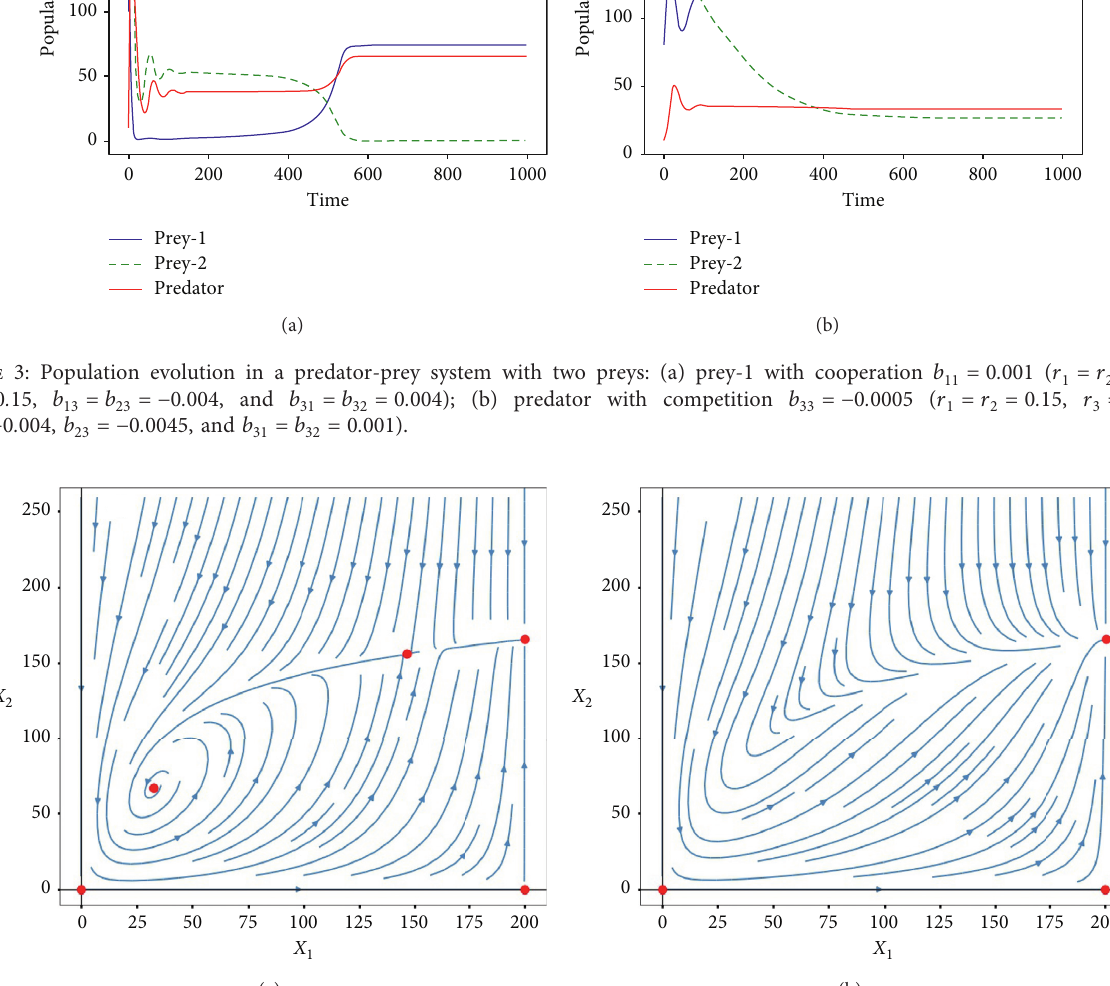
Figure 4: Phase space and trajectories for two populations involved in a predator-prey interaction. To the left, we have a case with a lower b � 0 . 0028 than to the right, b � 0 . 0035. Cooperation among prey allows a new intermediate solution, which is unstable and acts in the 11 11 same way as in Figure 1. Also, as greater cooperation decreases the predatory term, and the relation may become commensalistic at some � 0 . 15, r � − 0 . 15, b � − 0 . 0036, and b � 0 . points. Here, r 1 2 12 21 (Figure 5(b)). The corresponding time evolution